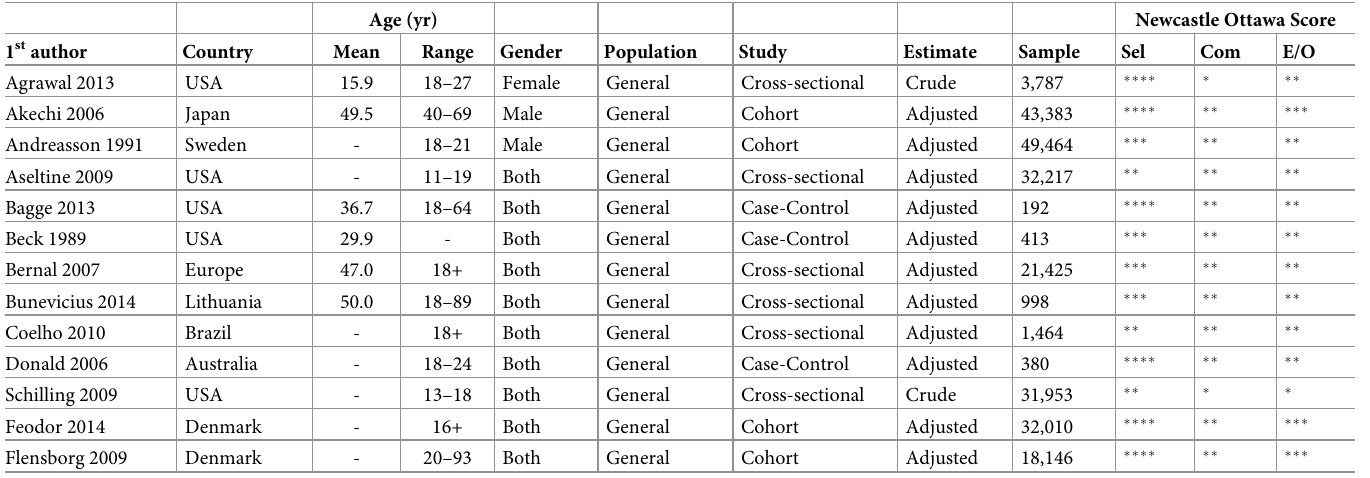
Table 1. Summary of study